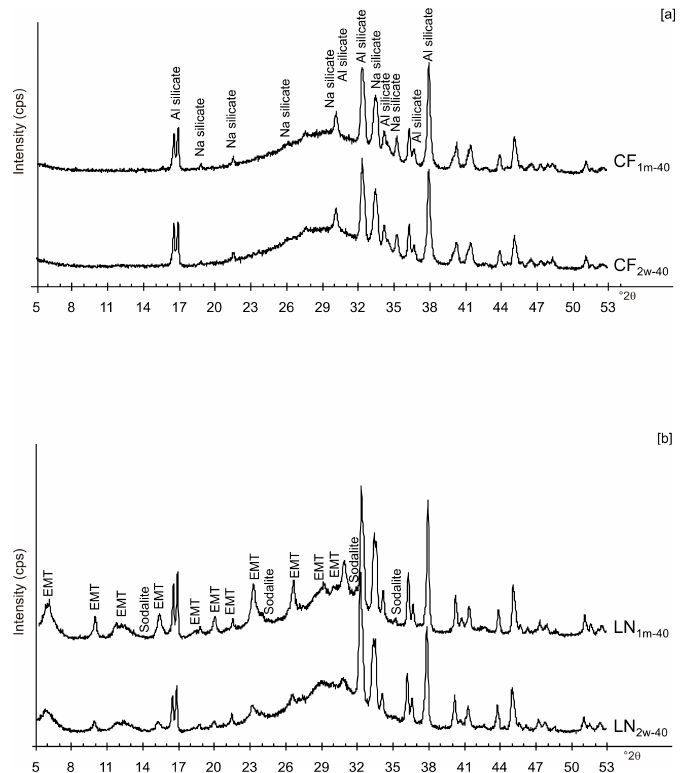
Figure 4. XRPD profiles of: ( a ) CF and ( b ) LN samples dried at 40 °C and analysed after 2 weeks and 1 month.